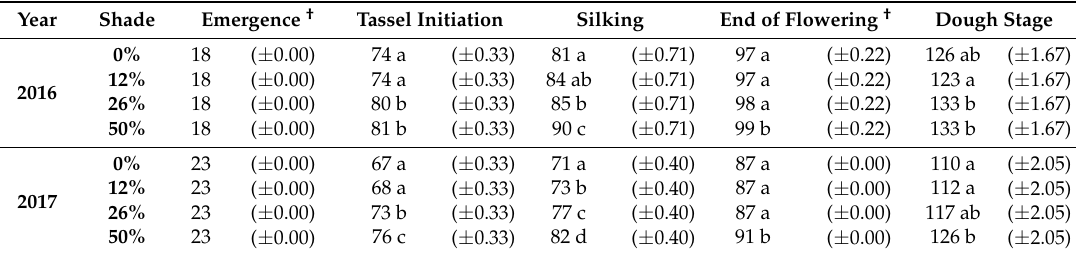
Table 3. Days after sowing (DAS) until the growing stages (GS) emergence (GS 09), tassel initiation (GS 51), silking (GS 61), end of flowering (GS 69), and dough stage (GS 85) under different shading levels (0, 12, 26, and 50%) in 2016 and 2017 and the standard error of means